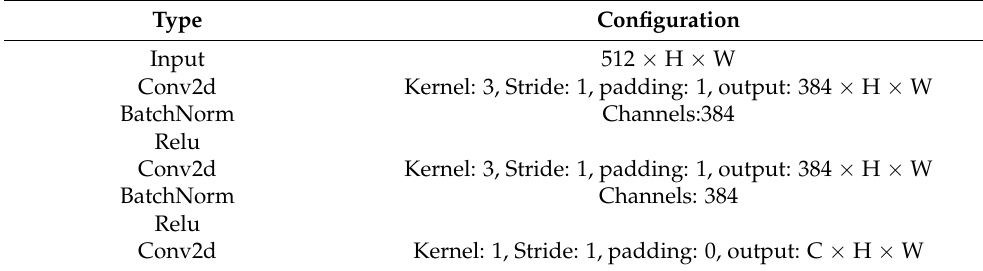
Figure 7. Full volume classification diagram. Table 1. Convolution classifier configuration information.